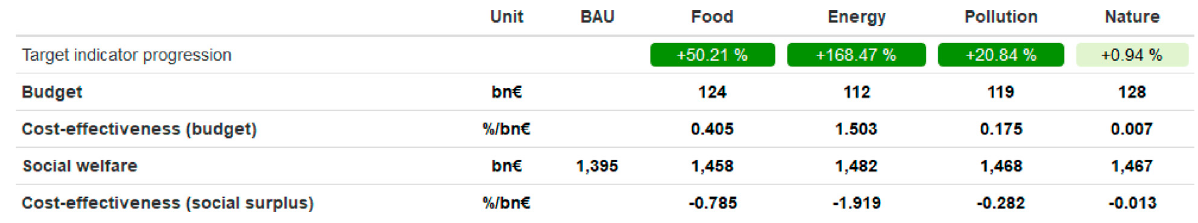
TABLE3Overalleffectivenessofthe4publicpolicyscenariosandtheBAU.HighlightedvaluesarecomputedincomparisontotheBAUandinregards with the scenarios target indicators, namely Food production for Food scenario, Energy production for Energy scenario, Pollution spreading for Pollution scenario, and Specialization Community Index for Nature scenario. All other indicators read in the speci fi ed units and compare across scenarios. For indicators computation details see 6.4.